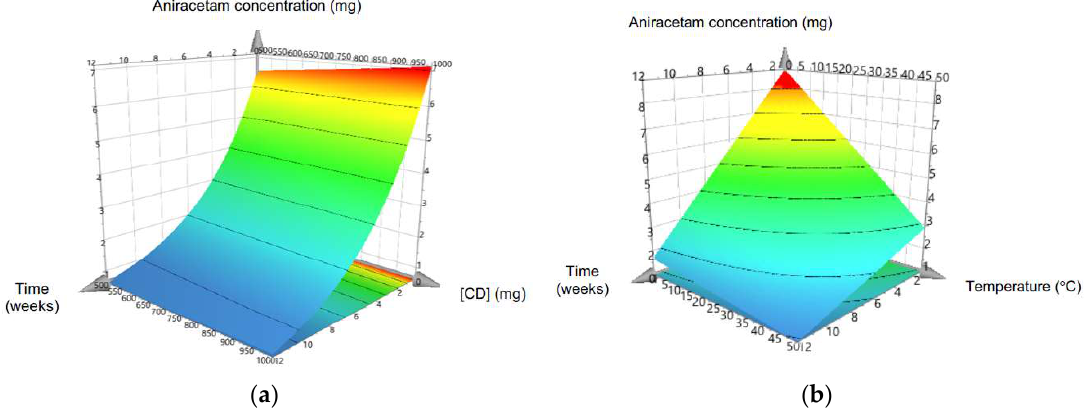
Figure 2. Response surface plots of remaining aniracetam concentration over time with varying ( a ) cyclodextrin concentration and ( b ) temperature over 12 weeks in different storage conditions. Plots were fitted using a multiple linear regression model in MODDE. Areas shown in red indicate storage conditions that preserved >90% of the initial aniracetam concentration.